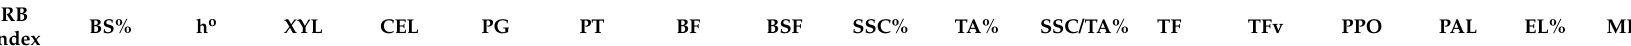
Table 1. Matrix showing Pearson’s correlation between the studied parameters of Superior Seedless grape, which was grown on four different rootstocks, during shelf